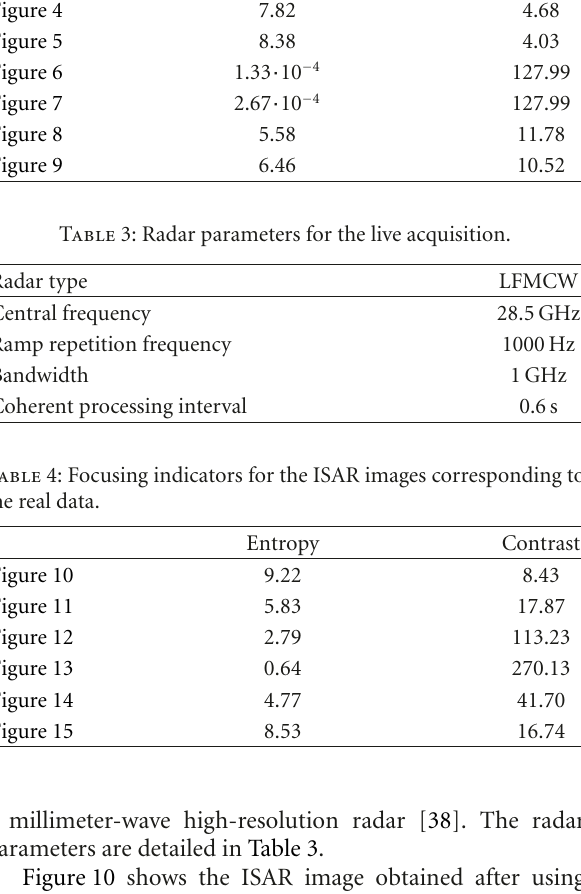
Figure 11: ISAR image after applying RDA to the real data for a reduced CPI (64 ramps).